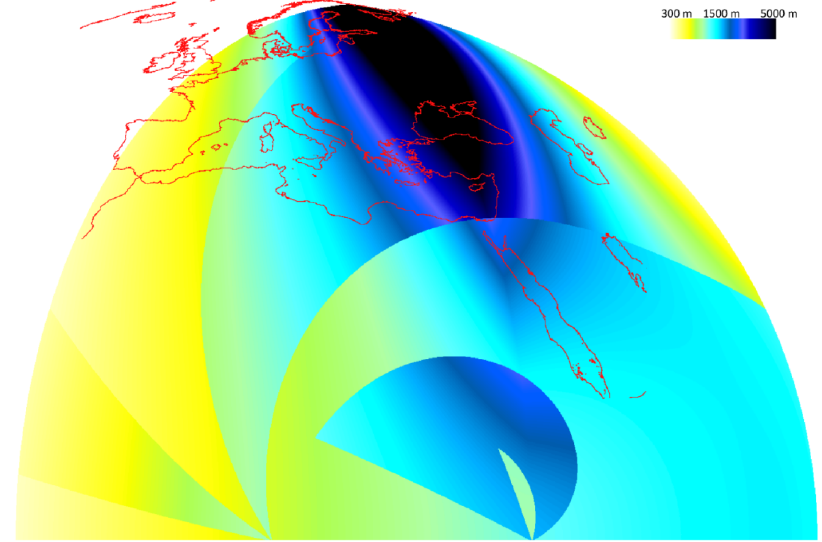
Figure 4. The minimum detectable cloud height considering that a parallax of exactly one pixel is observed. Note the discontinuities—the data depends on the direction of parallax—if it indicates a diagonal neighboring pixel, the results will be greater than when parallax indicates a neighboring pixel along the same line or column.